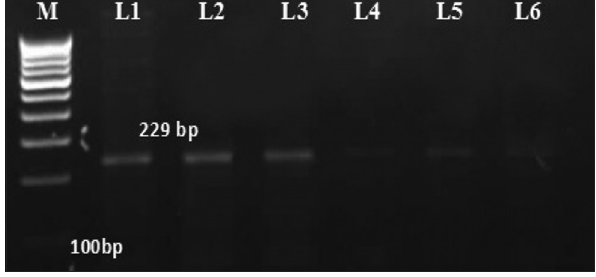
Figure-2: Mycobacterium avium subspecies paratuberculosis specific amplicons (229 bp) using IS